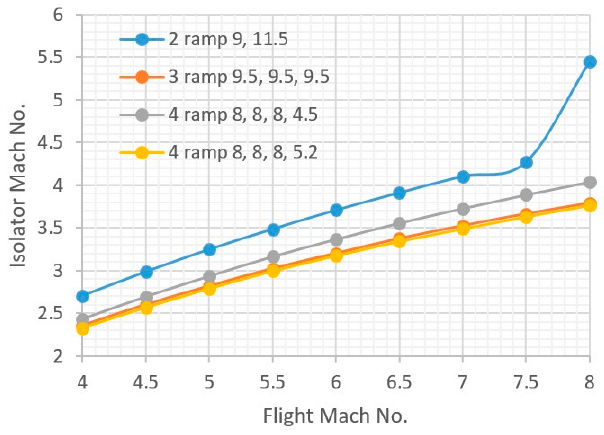
Figure 18. Mach number downstream of final shock wave for different starting Mach number.